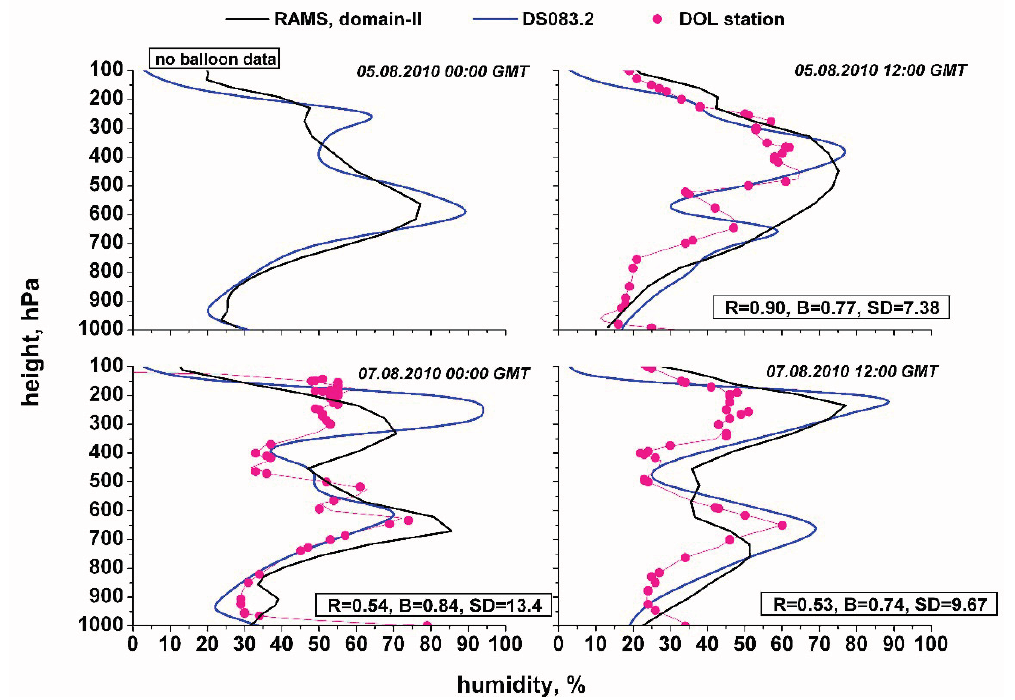
Figure 6. Experimental (balloons at the DOL station) and model (RAMS/HYPACT for the domain-II) humidity